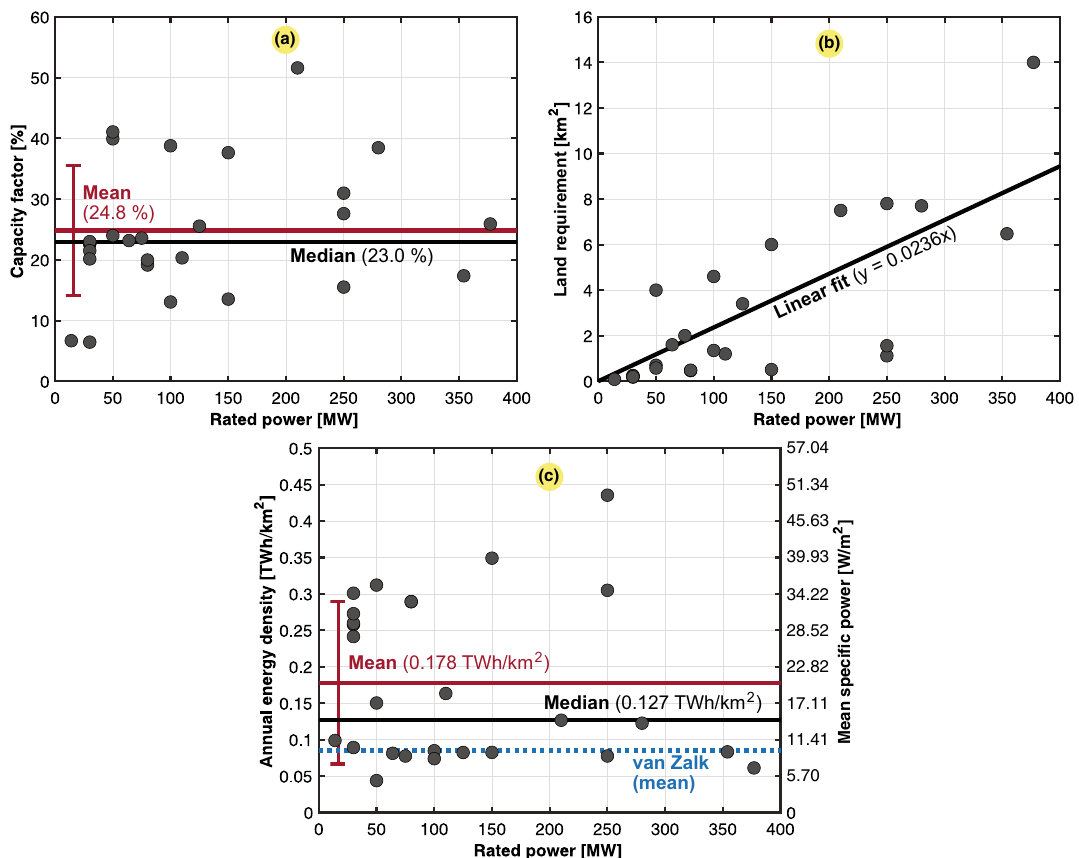
Figure 8. Case study of 27 concentrated solar power (CSP) plants, 17 in the United States, 7 in Spain, 1 in India, 1 in Chile, and 1 in South Africa. Typical, mean, median, and fitted values are also included. ( a ) Capacity factor ( C g ). ( b ) Land use ( A g ). ( c ) Annual energy density ( ε g ) or mean specific power ( p g ) with van Zalk and Behrens 3 as a